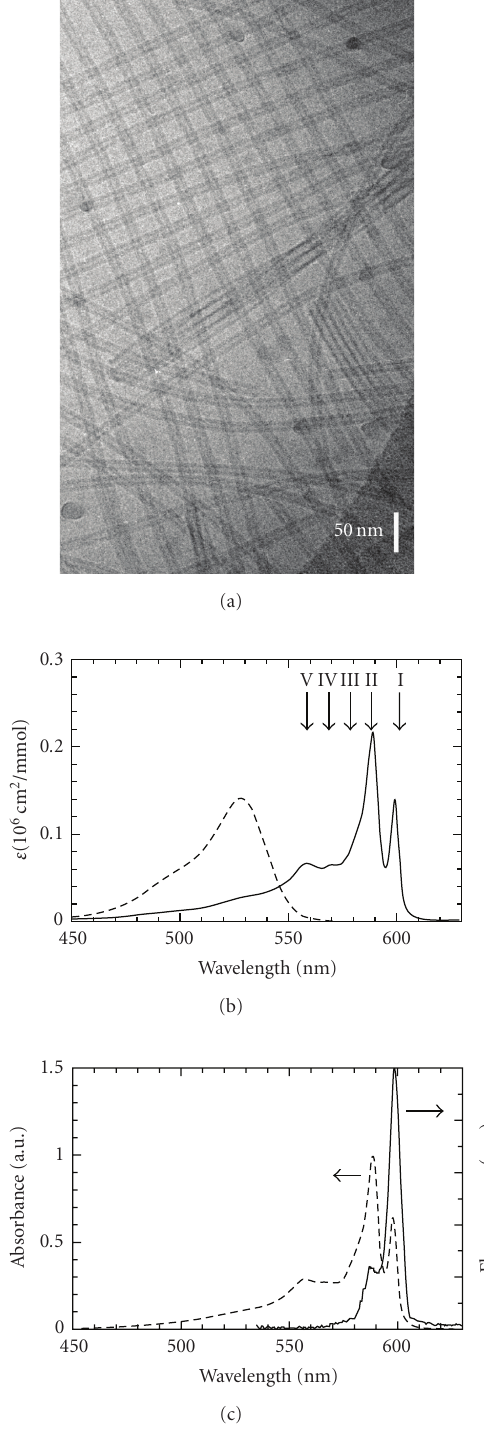
Figure 1: Optical spectra and cryo-TEM images of aggregates of C8S3 in water with 16 wt % of MeOH added. (a) Cryo-TEM im- ages of a 5 . 3 × 10 − 4 mol · l − 1 dye solution. The bar indicates 50 nm. (b) Absorption spectra of a 3 . 8 × 10 − 4 mol · l − 1 dye solution. The dashed line represents the absorption of monomers. (c) Fluores- cence emission (solid line) and excitation spectra (dashed line) of a 10 − 6 mol · l − 1 dye solution.